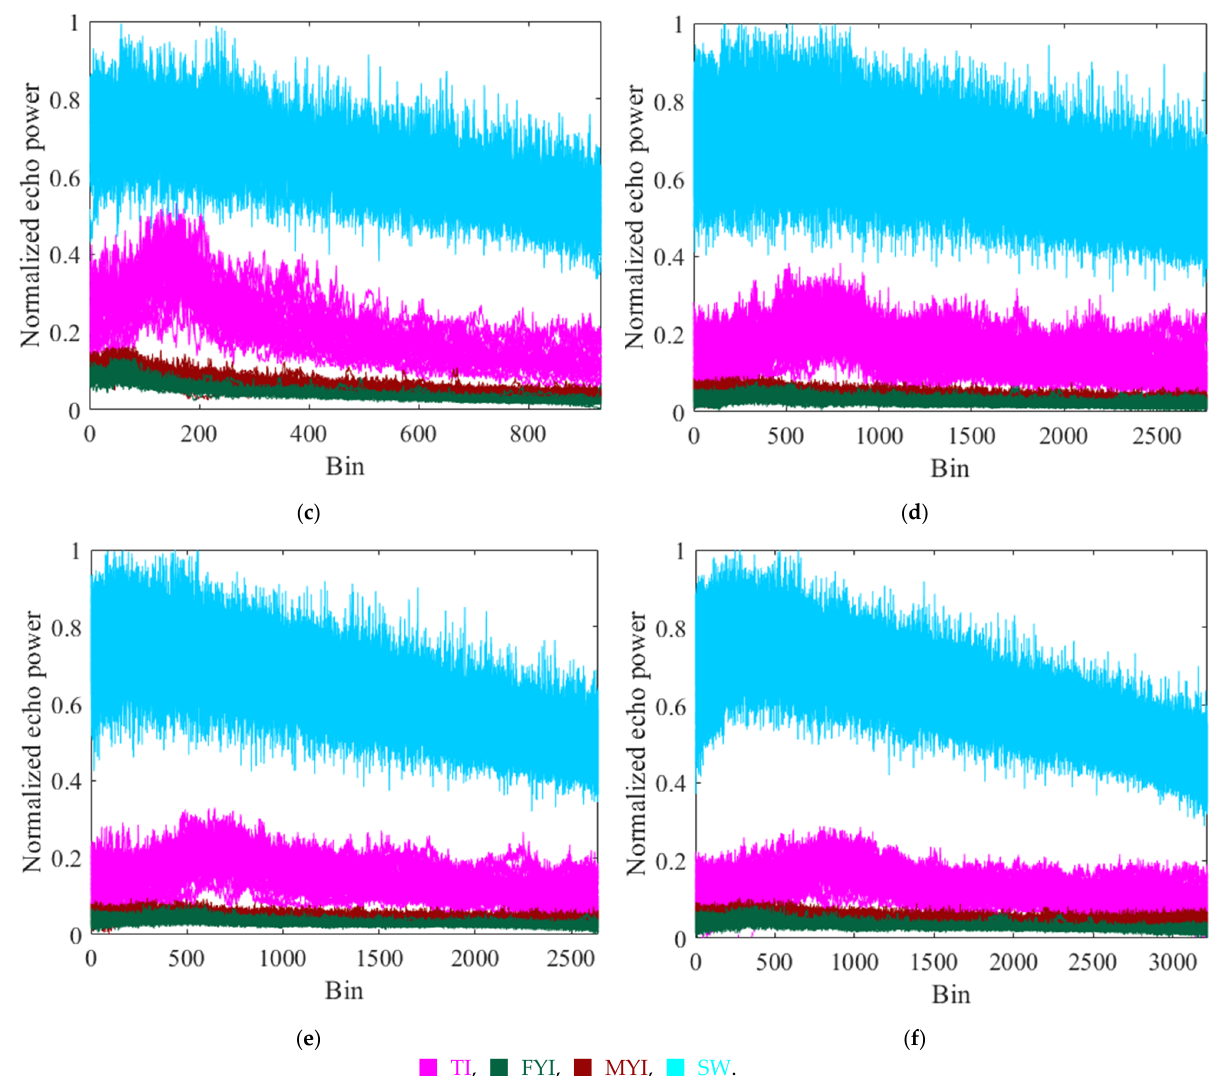
Figure 2. Examples of normalized SWIM waveforms of sea water and sea ice types at six incidence